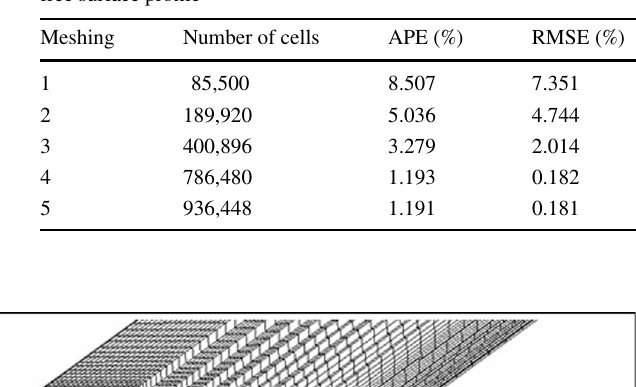
Table 2 Characteristics of griddings, APE and RMSE of